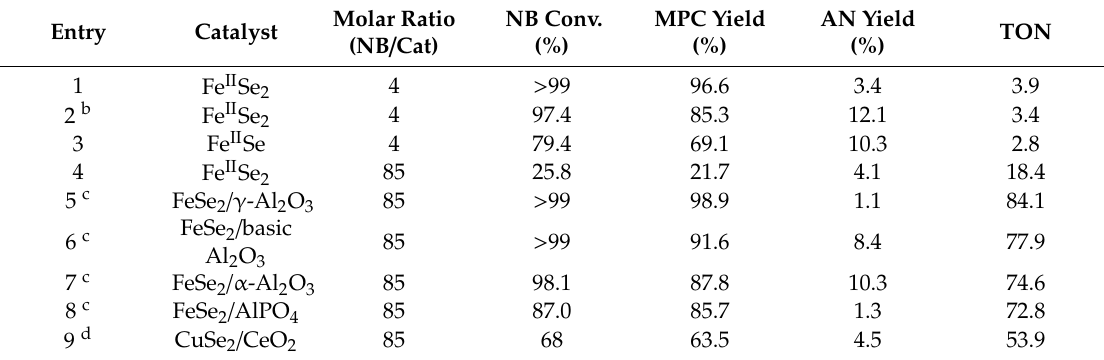
Table 2. Activities of various MSe 2 and their supported systems a